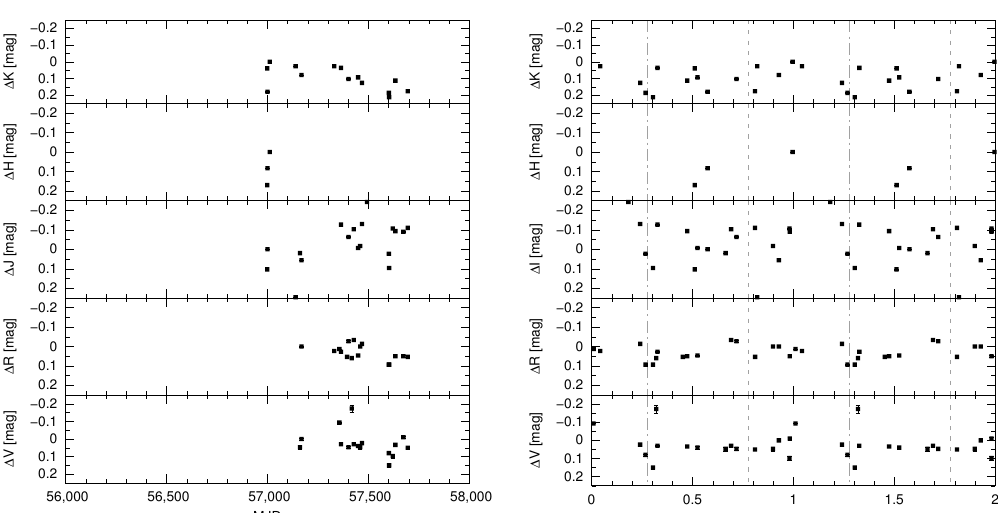
Figure 3. Optical and near-infrared photometry of LSI + 61 303 with Kanata/HONIR in the whole observation period ( left ) and regarding the phase ( right ). From top to bottom, differential magnitude in the Ks , H , J , R , and V bands are plotted. The vertical dash-dotted line and dashed line indicate periastron and apastron, respectively.